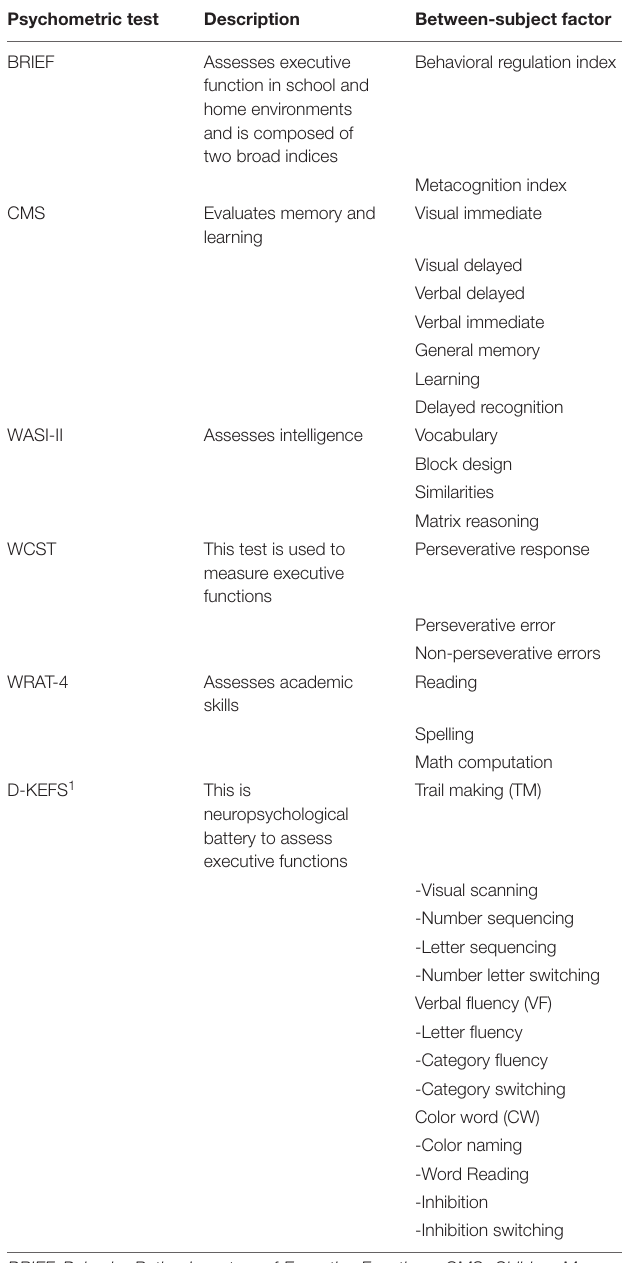
TABLE 1 | Psychometric test measures included as between-subject factor.